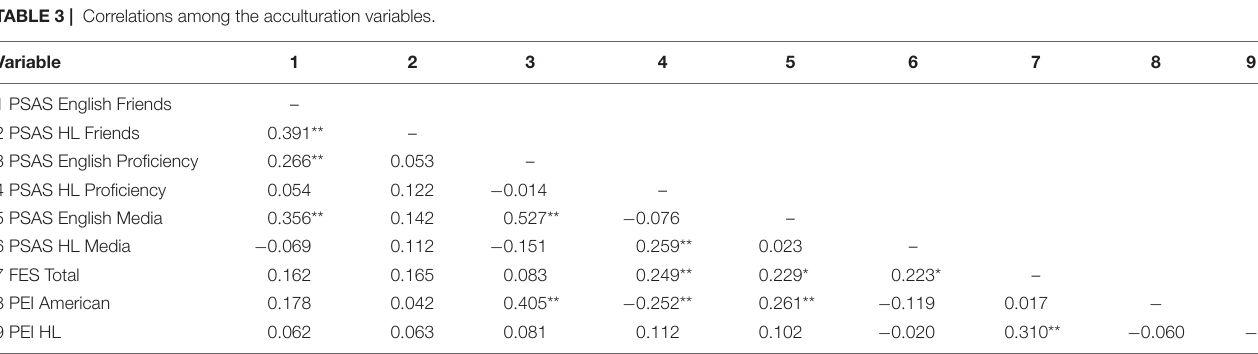
TABLE 3 | Correlations among the acculturation variables.